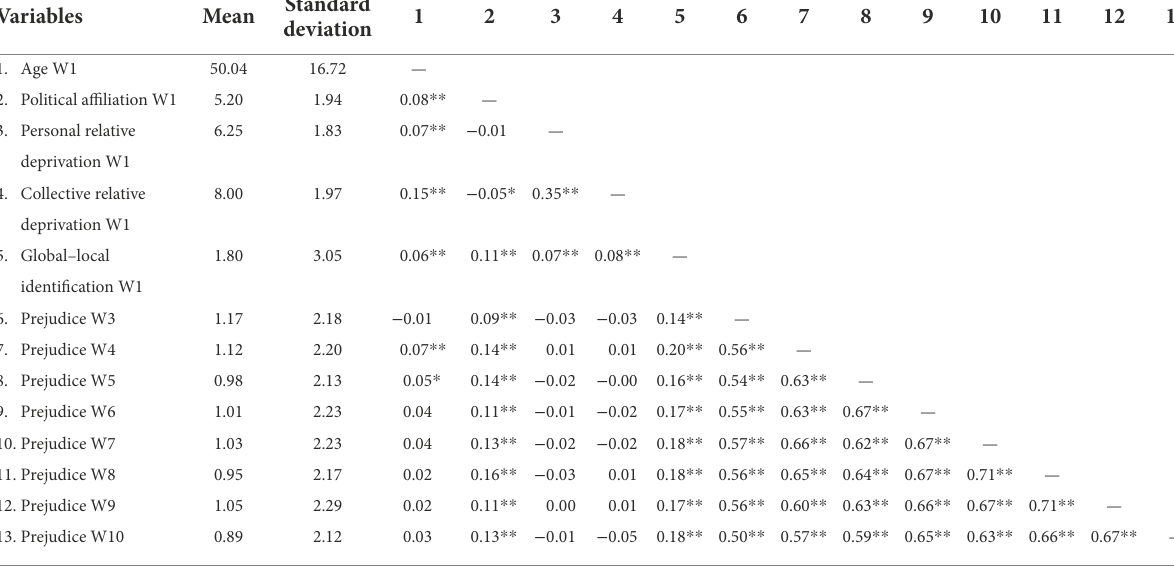
TABLE 4 Means, standard deviations, and correlation